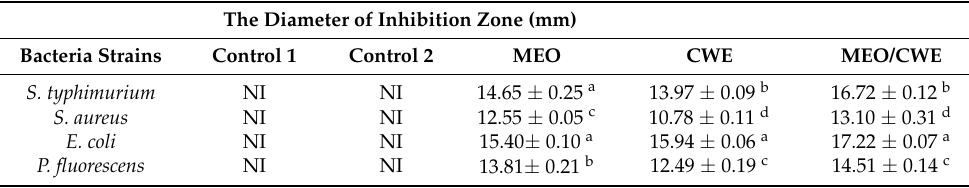
Table 5. Antimicrobial activity of active film containing MEO, CWE and the combination of MEO and CWE against different